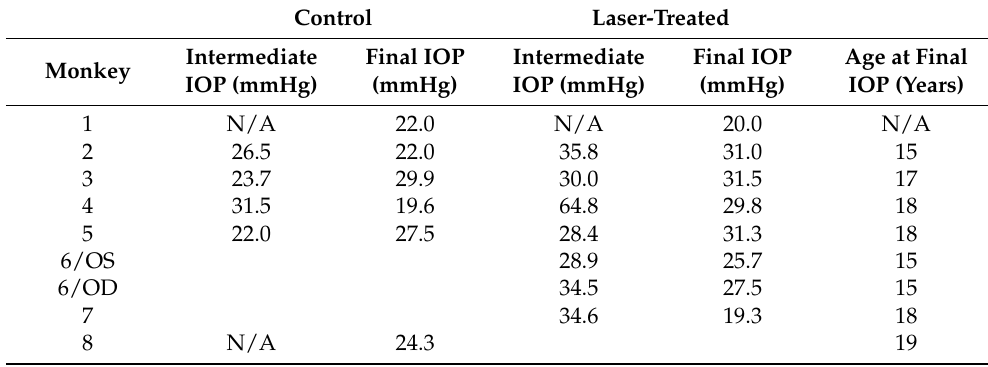
Table 1. Intermediate and final IOPs in control and laser-treated monkey